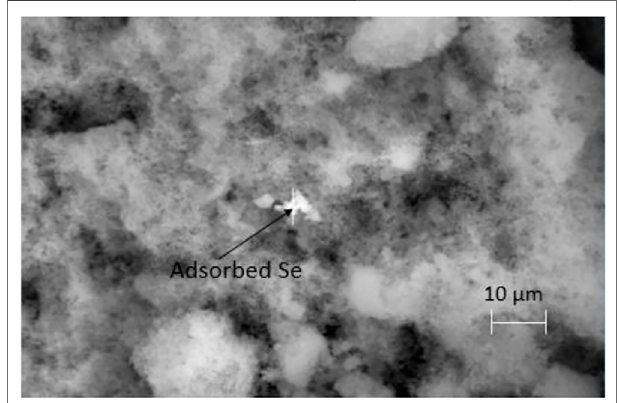
FIGURE 8 | SEM image of the precipitate collected at the end of the experiment carried out at pH 4 with 0.24 g L − 1 AR birnessite. Adsorbed Se is identi fi ed in a single bright spot here, however lighter spots in the vicinity were also shown to have signi fi cant but lower amounts of Se by weight.